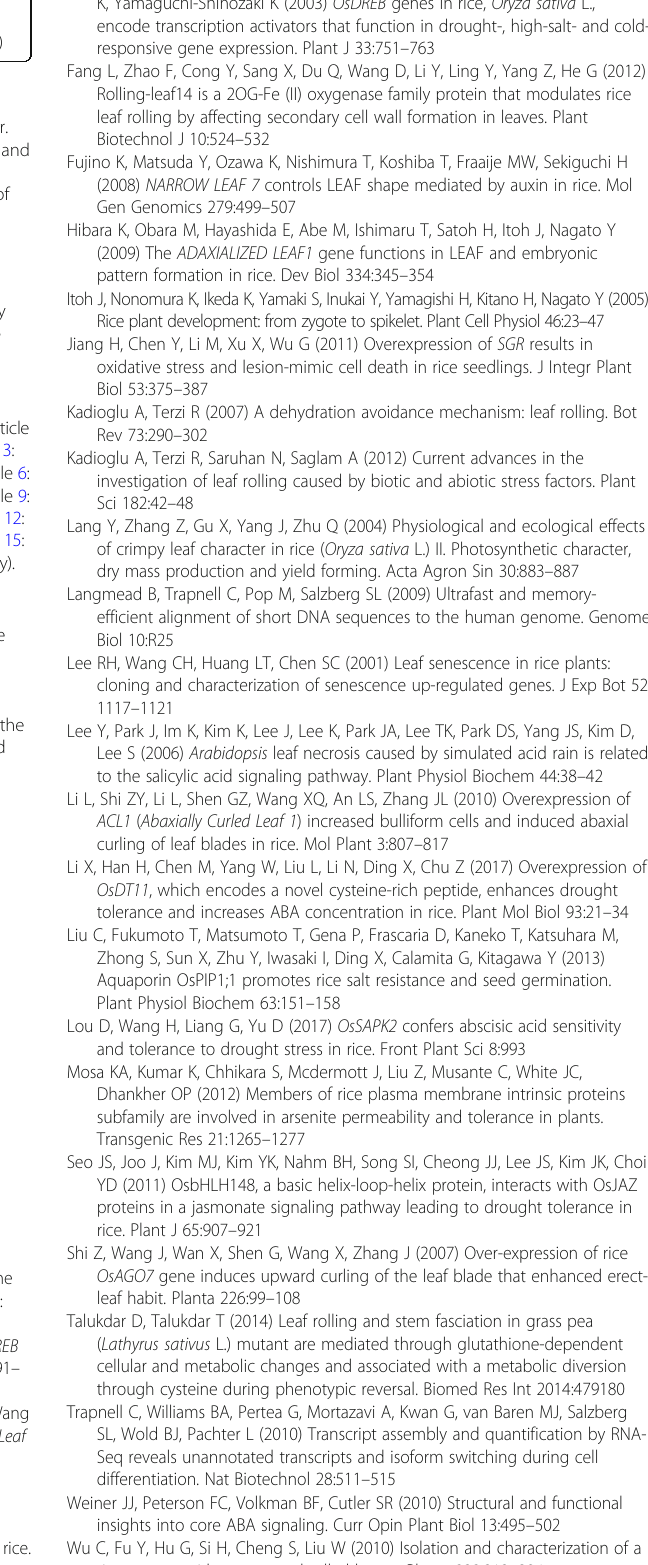
Additional file 16: Table S10. Plastid associated differentially expressed proteins in rel1-D . (XLSX 13 kb) Additional file 17: Table S11. Primers used in this study. (XLSX 12 kb)